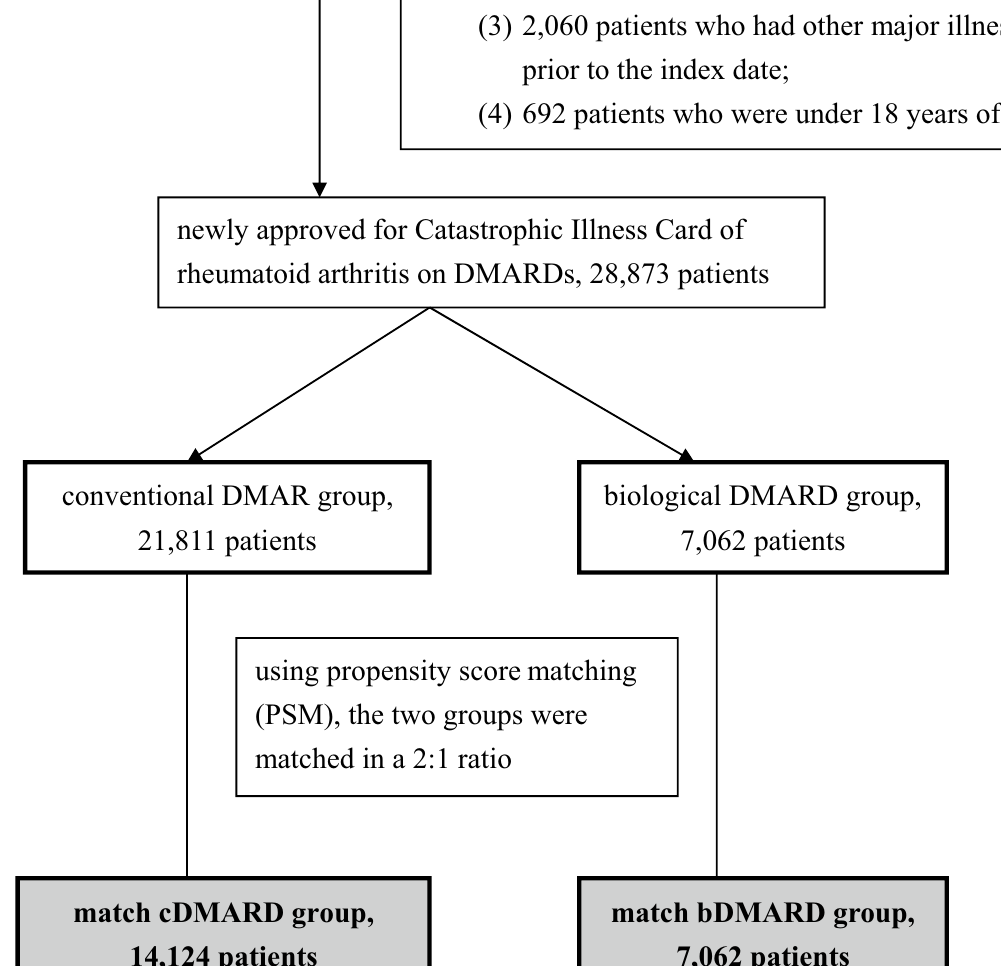
Figure 1. Flowchart showed the identification process of rheumatoid arthritis (RA) for the present study from NHIRD (data extracted from 1 January 2003 to 31 December 2016) using either conventional DMARD or biological